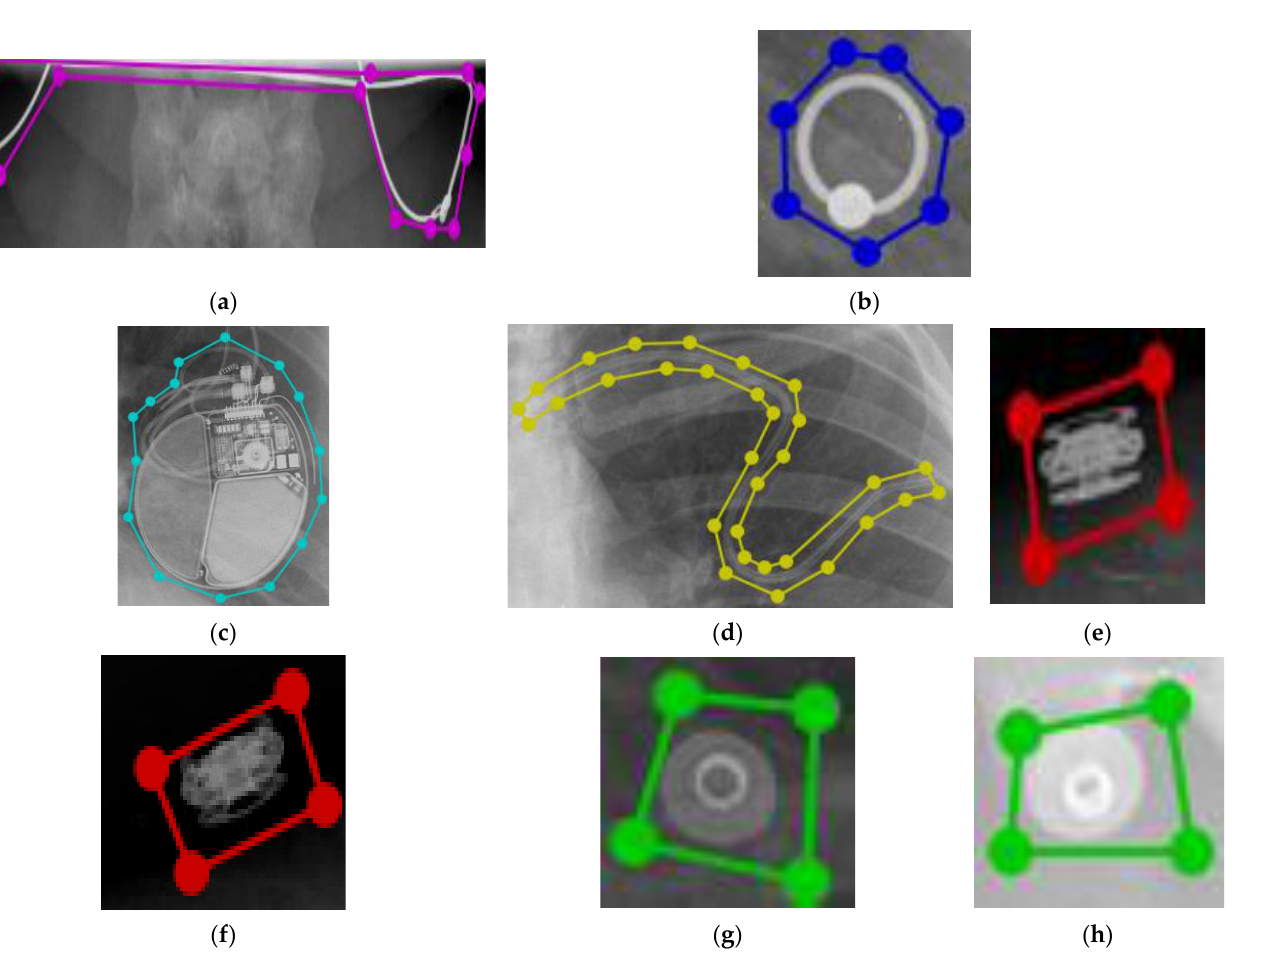
Figure 2. Closer view of NBFO: ( a ) chain, ( b ) ring; and BFO: ( c ) medical device, ( d ) tube, ( e ) – ( f ) buttons, ( g ) – ( h ) pinnode.